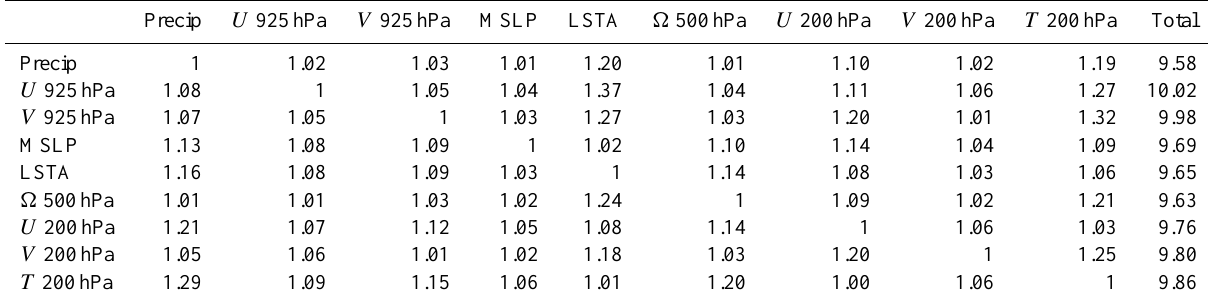
Table 3. As in Table 2 but for boreal summer,